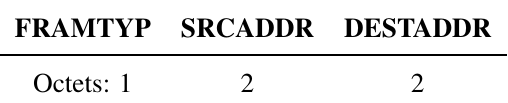
Table 4. Beacon frame